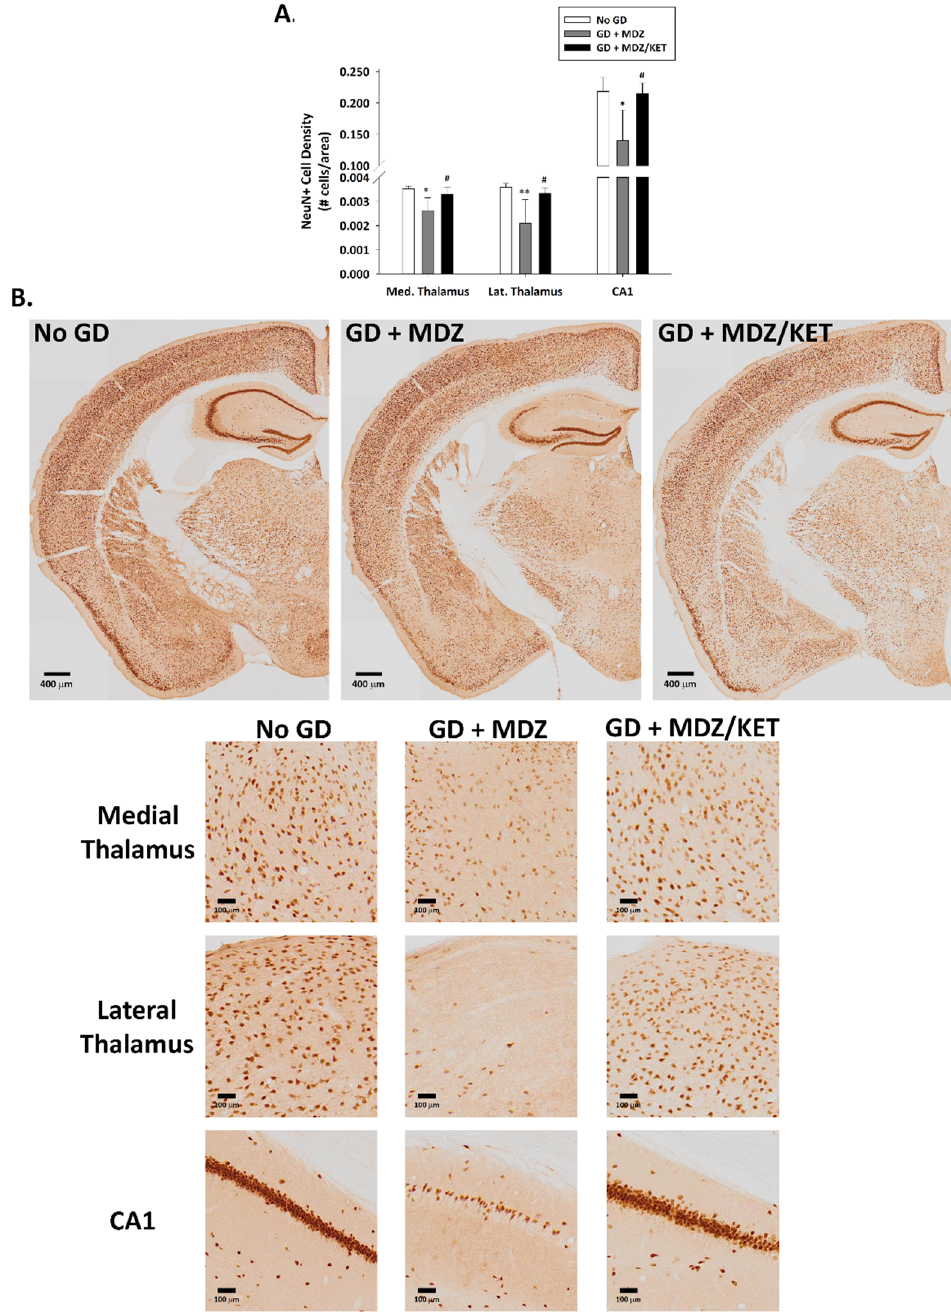
Figure 8. Effect of soman-induced status epilepticus and delayed midazolam monotherapy or midazolam/ketamine combination therapy on neuronal cell population in KIKO mice. At 2 weeks after SC soman-induced status epilepticus and delayed midazolam (GD + MDZ) or midazolam/ketamine (GD + MDZ/KET) therapy, KIKO mice were perfused, and brains collected for immunohistochemical processing with an antibody against NeuN, a neuronal nuclear protein, to visualize mature neurons. ( A ) NeuN-positive cells were counted and cell densities estimated in the medial thalamus, lateral thalamus, amygdala, piriform cortex, and CA1 region of the hippocampus from no agent controls (No GD; n = 4), GD + MDZ ( n = 3), and GD + MDZ/KET ( n = 5). Using stereology, loss of neurons was also confirmed in the CA1 region of the hippocampus. ( B ) Representative images, taken with a 0.40 NA 10X objective, are shown. * p < 0.05, ** p < 0.01, compared to No GD group; # p < 0.05, compared to GD + MDZ.